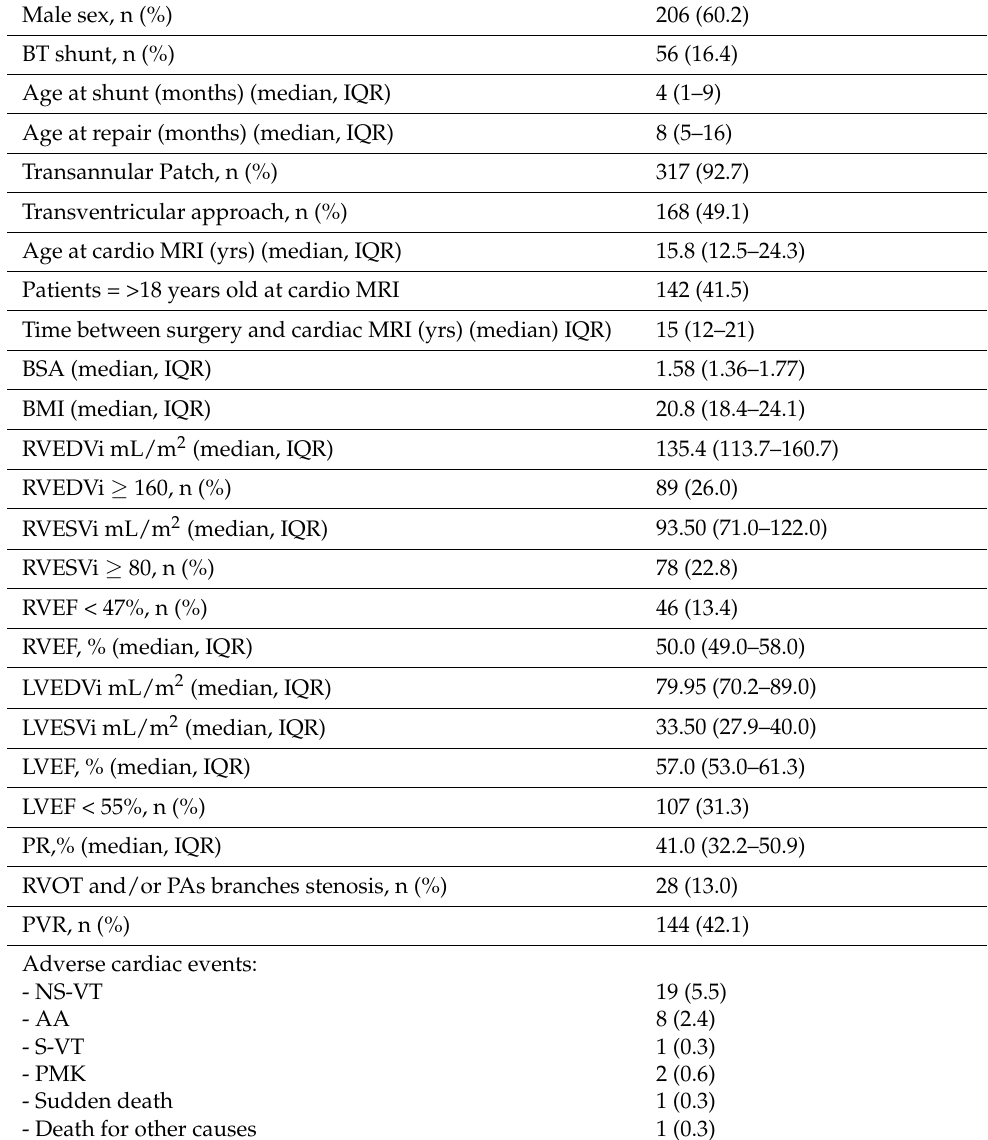
Table 1. Patients Characteristics. Legend: BT shunt = Blalock–Taussig shunt; TP = transannular patch; BSA = body surface area; BMI = body mass index; RVEDVi = right ventricular end-diastolic volume indexed by BSA; RVESVi = right ventricular end-systolic volume indexed by BSA; RVEF = right ventricular ejection fraction; LVEDVi = left ventricular end-diastolic volume indexed by BSA; LVESVi = left ventricular end-systolic volume indexed by BSA; LVEF = left ventricular ejection fraction; PR = pulmonary regurgitation fraction; RVOT = right ventricular outflow tract; PAs = pulmonary arteries; PVR = pulmonary valve replacement; NS-VT = non-sustained ventricular arrhythmias; S-VT = sustained ventricular arrhythmias; AA = Atrial arrhythmia; PMK =